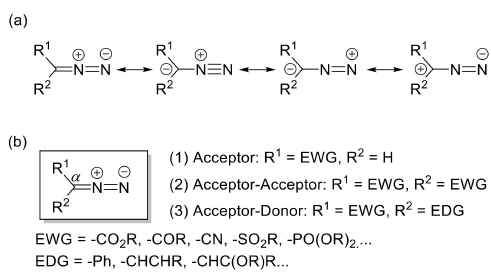
Figure1. ( a )Resonancestructuresofdiazocompounds; ( b